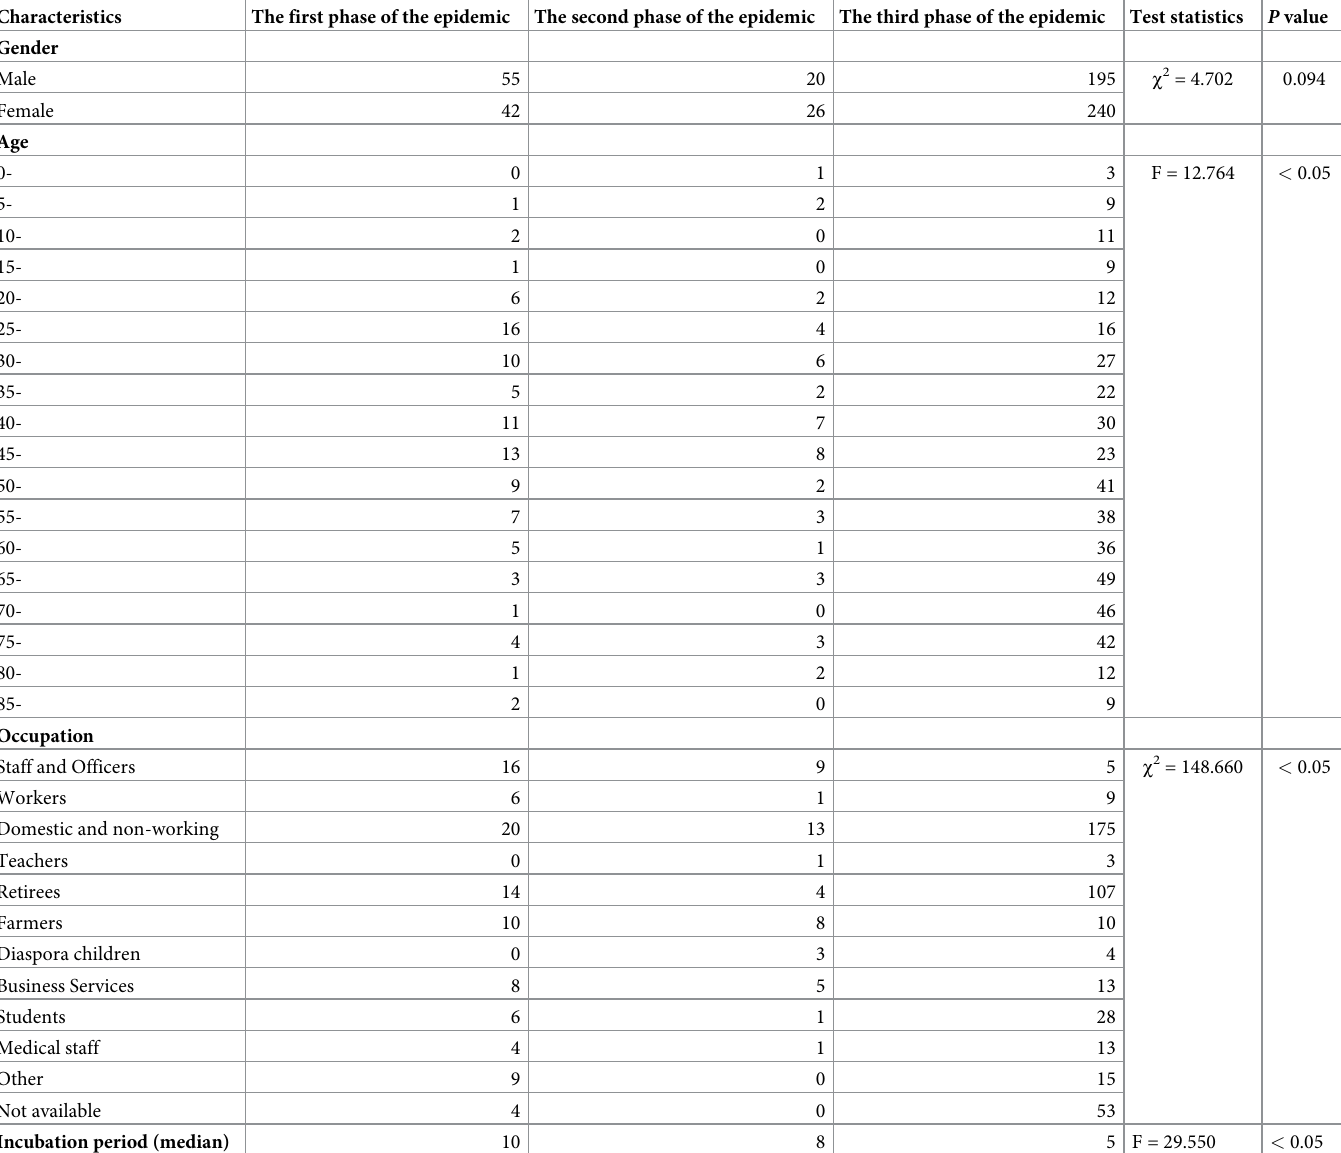
Table 1. Population characteristics of the three phases of outbreaks in Jilin